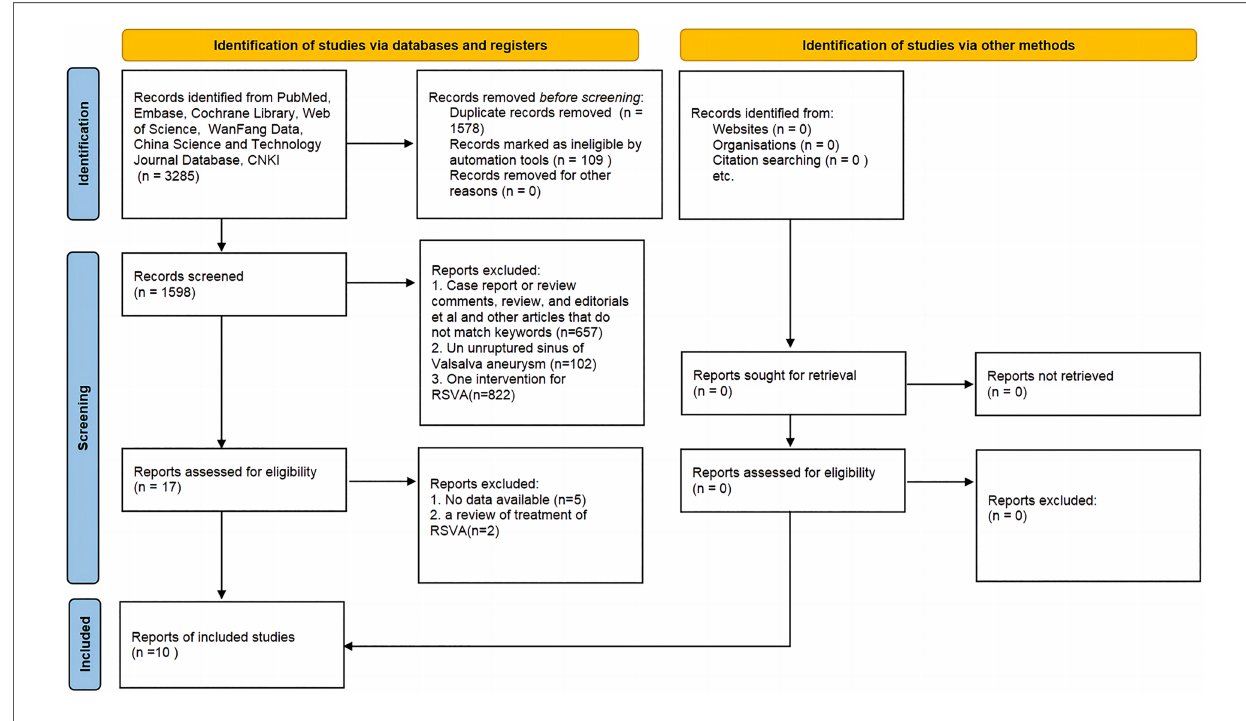
FIGURE 1 PRISMA fl ow